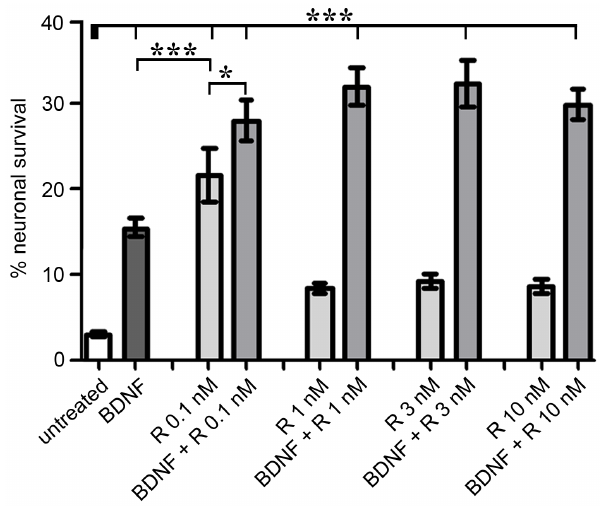
Figure 1. Rolipram treatment alone and in combination with BDNF improved the survival of SGN. The neuronal survival was assessed by the amount of surviving neurons after a cultivation period of 48 h in relation to the seeding control (% neuronal survival). Rolipram (R) applied at a concentration of 0.1 nM enhanced the survival of SGN after serum deprivation and resulted in a significant higher survival rate when compared to the untreated group and to the positive control (treated with BDNF [50 ng/ml]). Elevated Rolipram concentrations (1, 3, 10 nM) did not result in an increased neuronal survival compared to the untreated control group. Co-treatment with Rolipram and BDNF caused an additional increase of neuronal survival independently of varying Rolipram concentrations. Values are given as mean 6 SEM; N=4; n=3; One-way ANOVA with Tukey’s multiple post hoc test was used to compare means: *p , 0.05; **p , 0.01; ***p , 0.001. Reference of the significance is marked by the thick bar. N quotes the number of independent experiments; n gives the number of repetitions of each condition within one experiment.